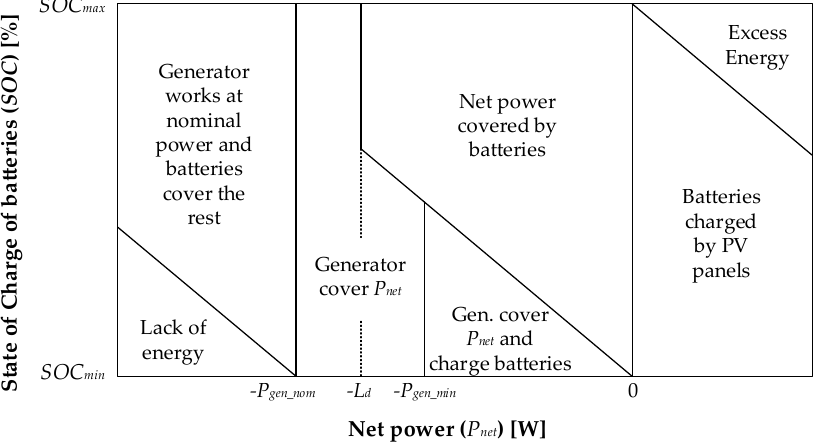
Figure 11. Simplified diagram of “load following-frugal” strategy [140].